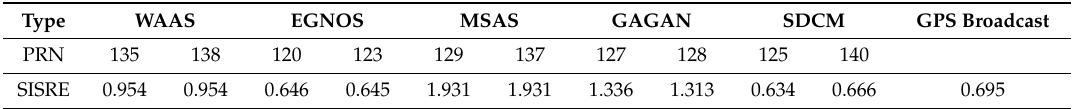
Table 2. The signal-in-space range error (SISRE) values of SBAS-derived and GPS broadcast orbits& clocks (unit: meters).